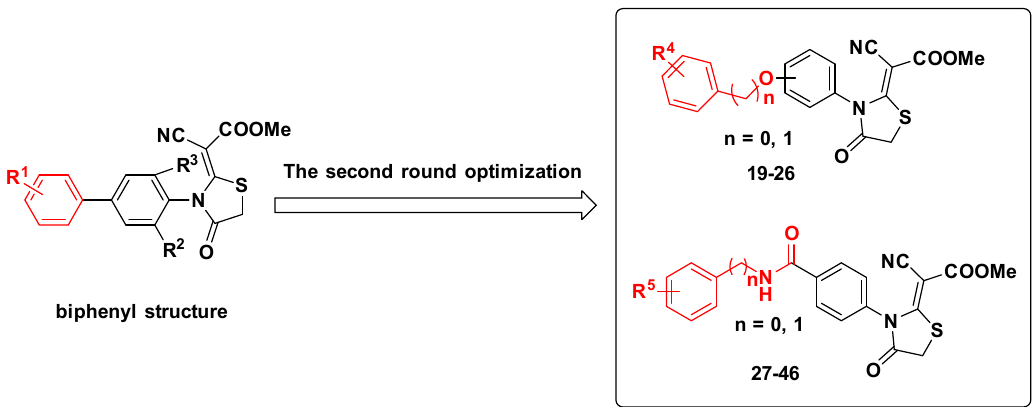
Figure 7. Design and modification strategies of 4-thiazolidinones with biphenyl ether and amide as h DHODH inhibitors .